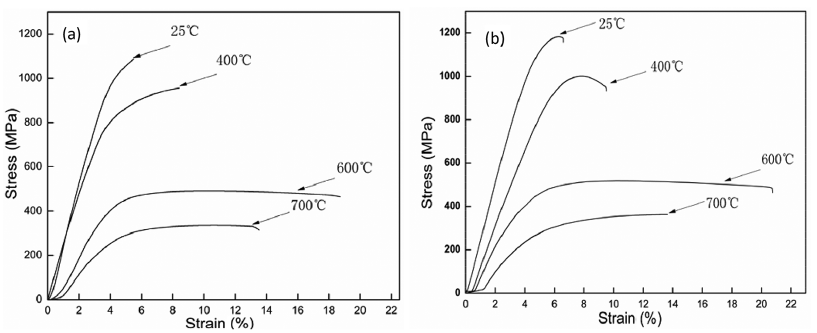
Figure 3: (a), (b) Stress – strain curve of HIPed and heat-treated ODS steels at different